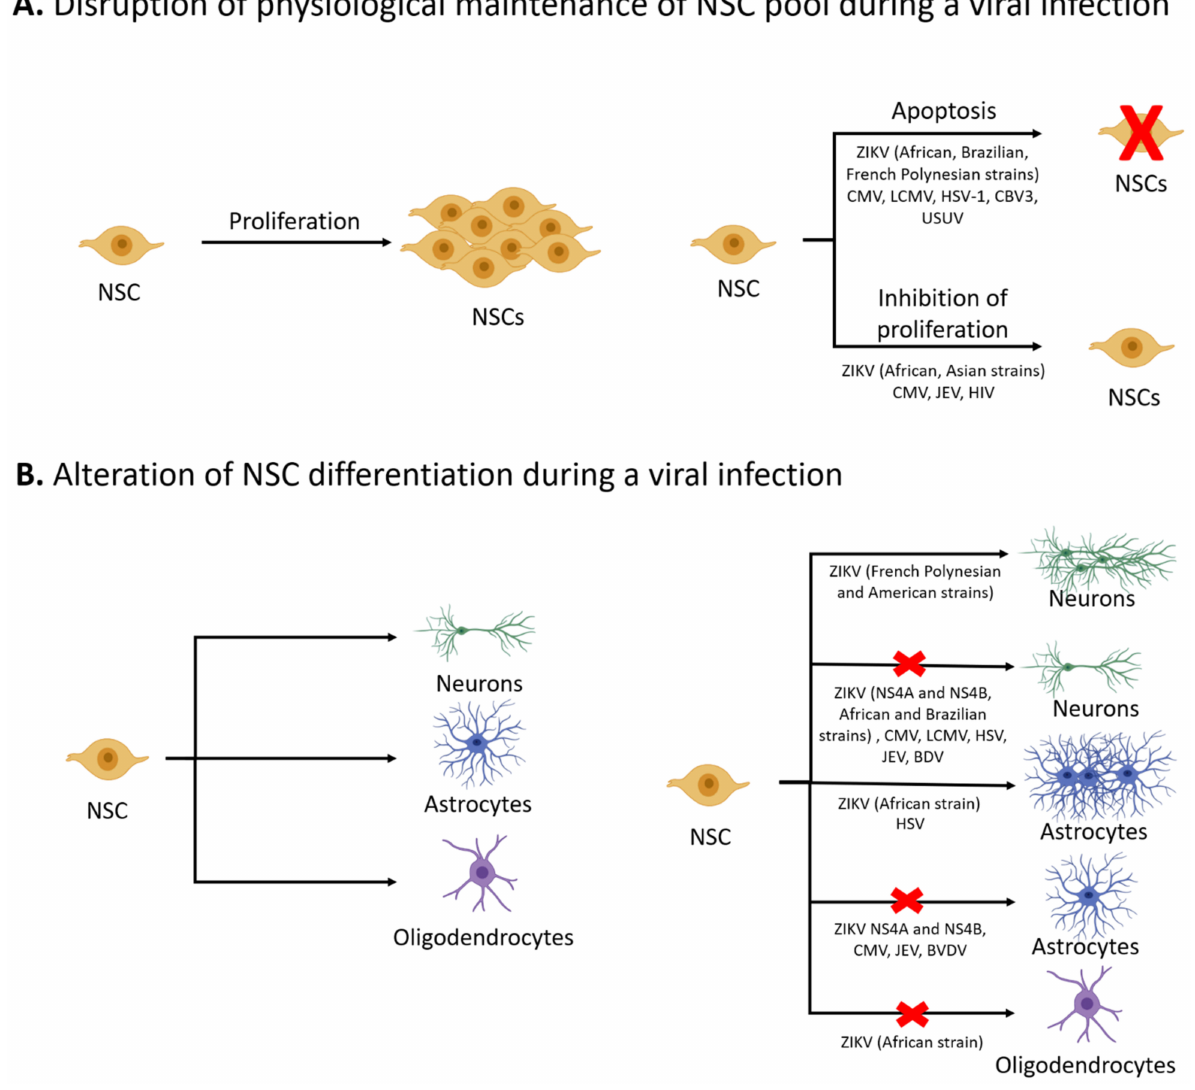
Figure 1. Effects of viral infections on the physiological functions of NSCs. Under physiological conditions, NSCs can proliferate via symmetric cell division to maintain the NSC pool. Viral infections such as ZIKV and CMV can deplete the NSC pool by inducing apoptosis or reducing proliferation of NSCs ( A ) Based upon tightly coordinated developmental cues, NSCs undergo differentiation to yield neurons, astrocytes, or oligodendrocytes. Viral infections can result in aberrant differentiation of NSCs, with many viruses leading to reduced neurogenesis ( B ) Some viruses, such as CMV and JEV, can inhibit both neurogenesis and gliogenesis. ZIKV impacts differentiation in a strain-dependent manner; the ZIKV Brazilian strain (BR_ZIKV_AB_ES) reduced neurogenesis whereas ZIKV French Polynesian strain (H/PF/2013) and ZIKV American strain (FB-GWUH-2016) increased the number of cells expressing a neuronal marker (Tuj1). Viruses can also affect the formation of glia, with many viruses blocking astrogliogenesis and ZIKV African strain (IB H 30656) blocking the formation of